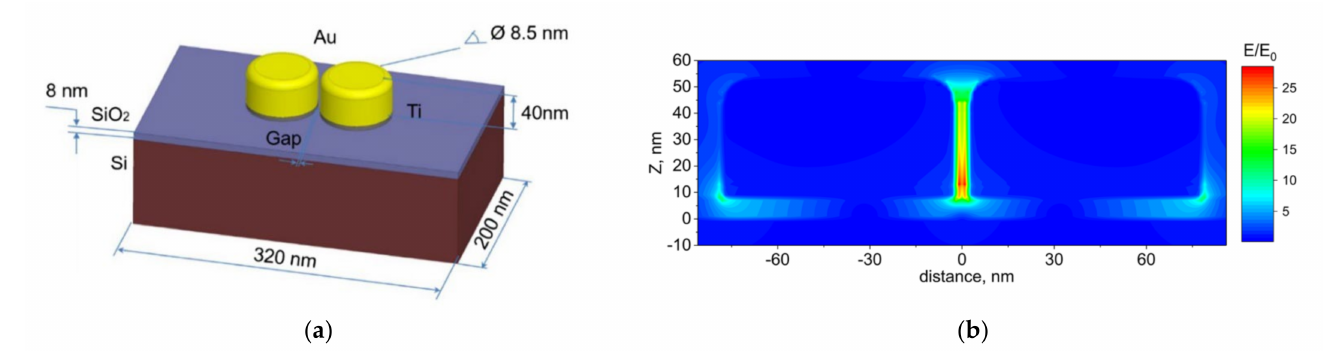
Figure 10. Scheme of the model used to calculate the EM enhancement: ( a ) two gold nanodisks formed on a Si surface with an 8 nm thick SiO 2 layer. ( b ) Side-view image of the electric field distribution near the two nanodisks. The electric field near the nanodisks was normalized to the incident electric field. Reprinted with permission from [34]. Copyright 2019, Springer.